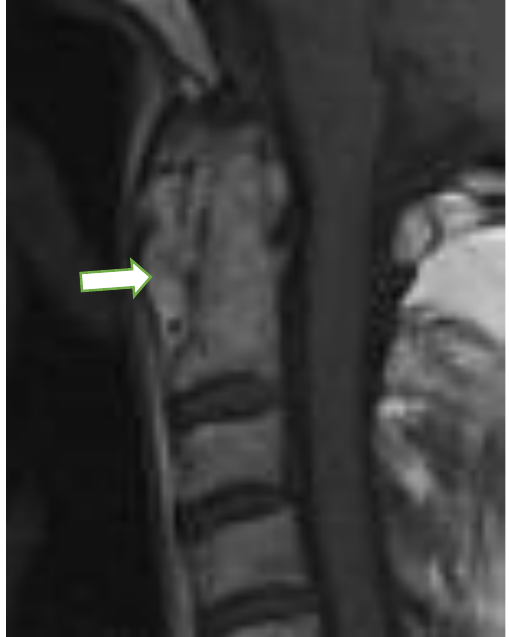
Figure 3. Sagittal postcontrast MRI, T1-w image in a 76-year-old female with rheumatoid arthritis with pannus formation in periodontal area (arrow). MRI: magnetic resonance imaging.